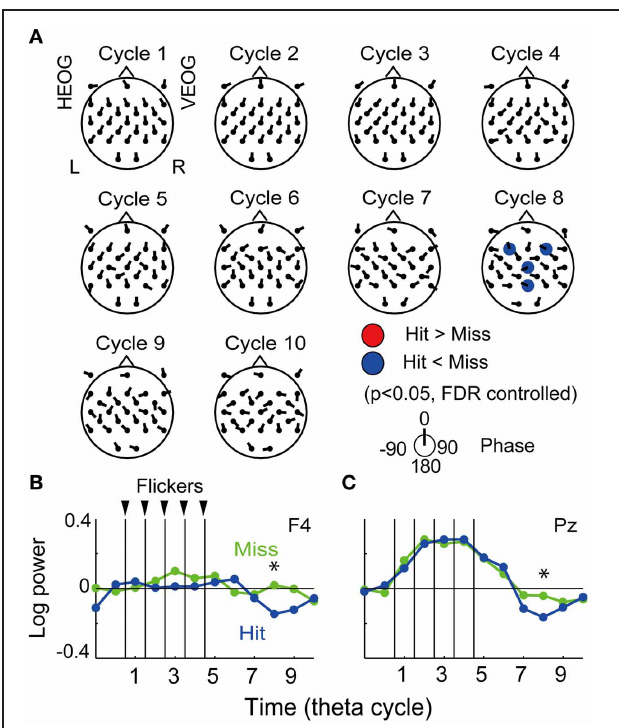
FIGURE 5 | Subsequent recall-related EEG phase locking. (A) Topographical maps of average p -values at each cycle showing differences between EEG phase locking in the Hit condition and that in the Miss condition. Direction of arrow at each electrode location indicates a mean EEG phase in the Hit condition against that in the Miss condition. (B,C) Temporal evolution of average t -values comparing phase locking in the Hit condition with that in the Miss condition (at FC6 and Pz). Asterisks indicate significant difference between phase locking in the Hit condition and that in the Miss